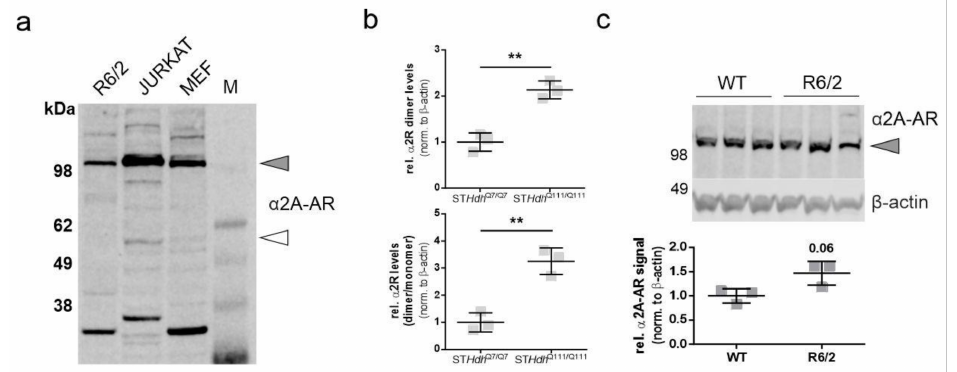
Figure A1. α 2A-AR levels in ST Hdh cells and R6/2 mice. ( a ) Western blot of α 2A-AR in R6/2 cortex homogenates, Jurkat homogenates, and MEF Q111/Q111 cells. Monomeric form indicated by unfilled arrowhead, dimeric form by grey arrowhead. ( b ) Quantification of immunoblots shown in Figure 2a with normalization to β - actin. ** p = 0.0021 (dimer) and ** p = 0.004 (dimer/monomer) ( c ) Western blot and quantification of α 2A-AR levels in cortex homogenates of 11 \ -week-old R6/2 mice. Unpaired t- test with Welch’s correction p = 0.06, n = 3.